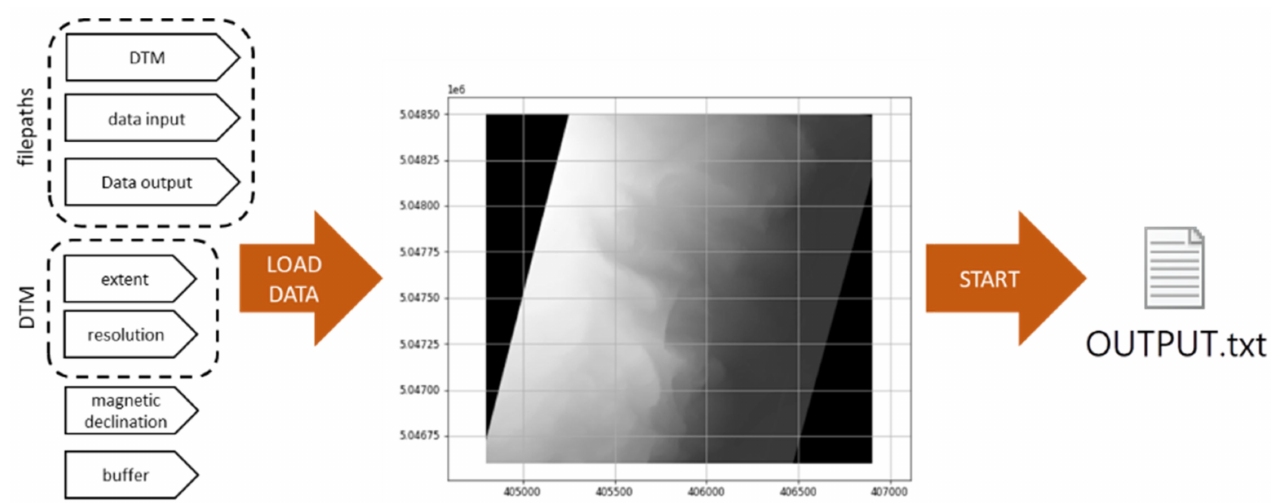
Figure 10. CoordFinder data requirements and operative